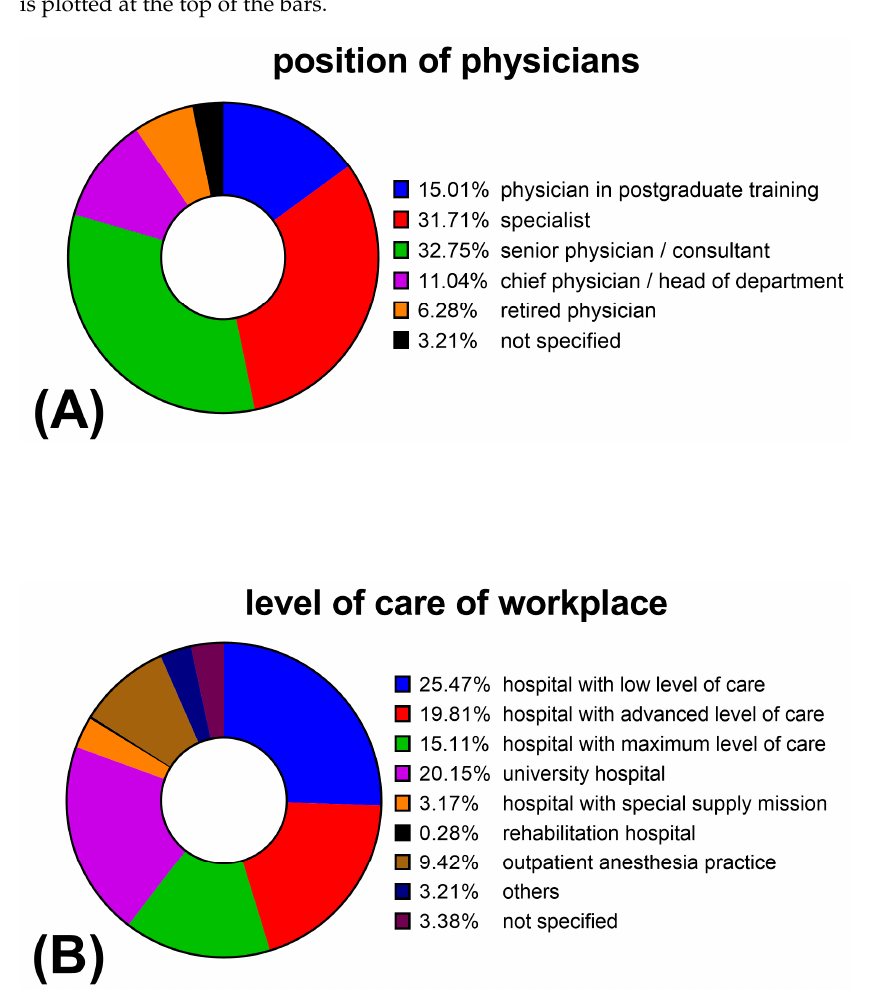
Figure 3. Representation of sociodemographic aspects of the survey participants (n = 2898): Pie chart ( A ) shows distribution of position/qualification of physicians. Pie chart ( B ) shows the physicians' workplace.